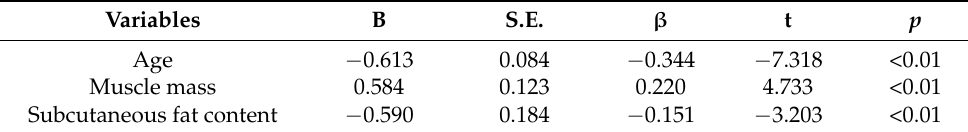
Table 3. Multiple linear regression analysis of bone strength index and partial